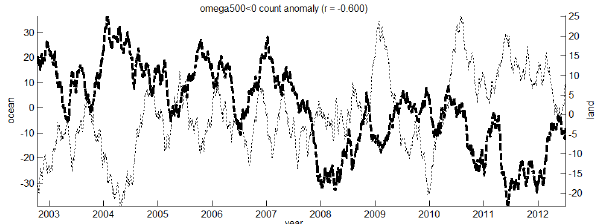
Figure 9. Overlay of anomalies of the daily(day+night overpasses) count of the 2.5 degree cells 695 Fig. 9. Anomalies of the daily (day+night overpasses) count of the identified with ω 500 <0 for ocean (bold) and land, smoothed with a 96-day running average. 696 2.5 degree cells identified with ω 500 <0 for ocean (bold) and